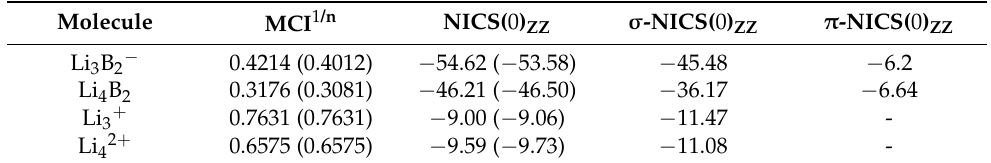
Table 2. MCI 1/n , NICS ( 0 ) The results obtained with the ma-def2-TZVP basis set are given in the brackets.